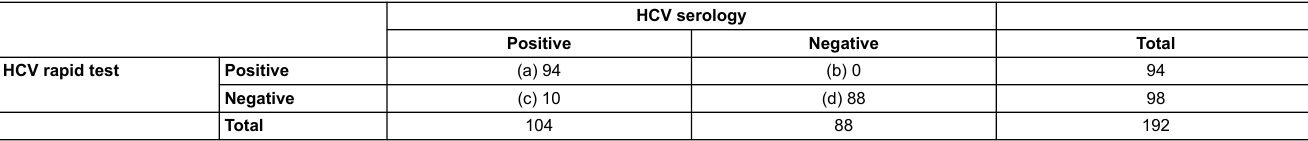
Table 5: Performance of the HCV antibody rapid test (OraQuick ® ).